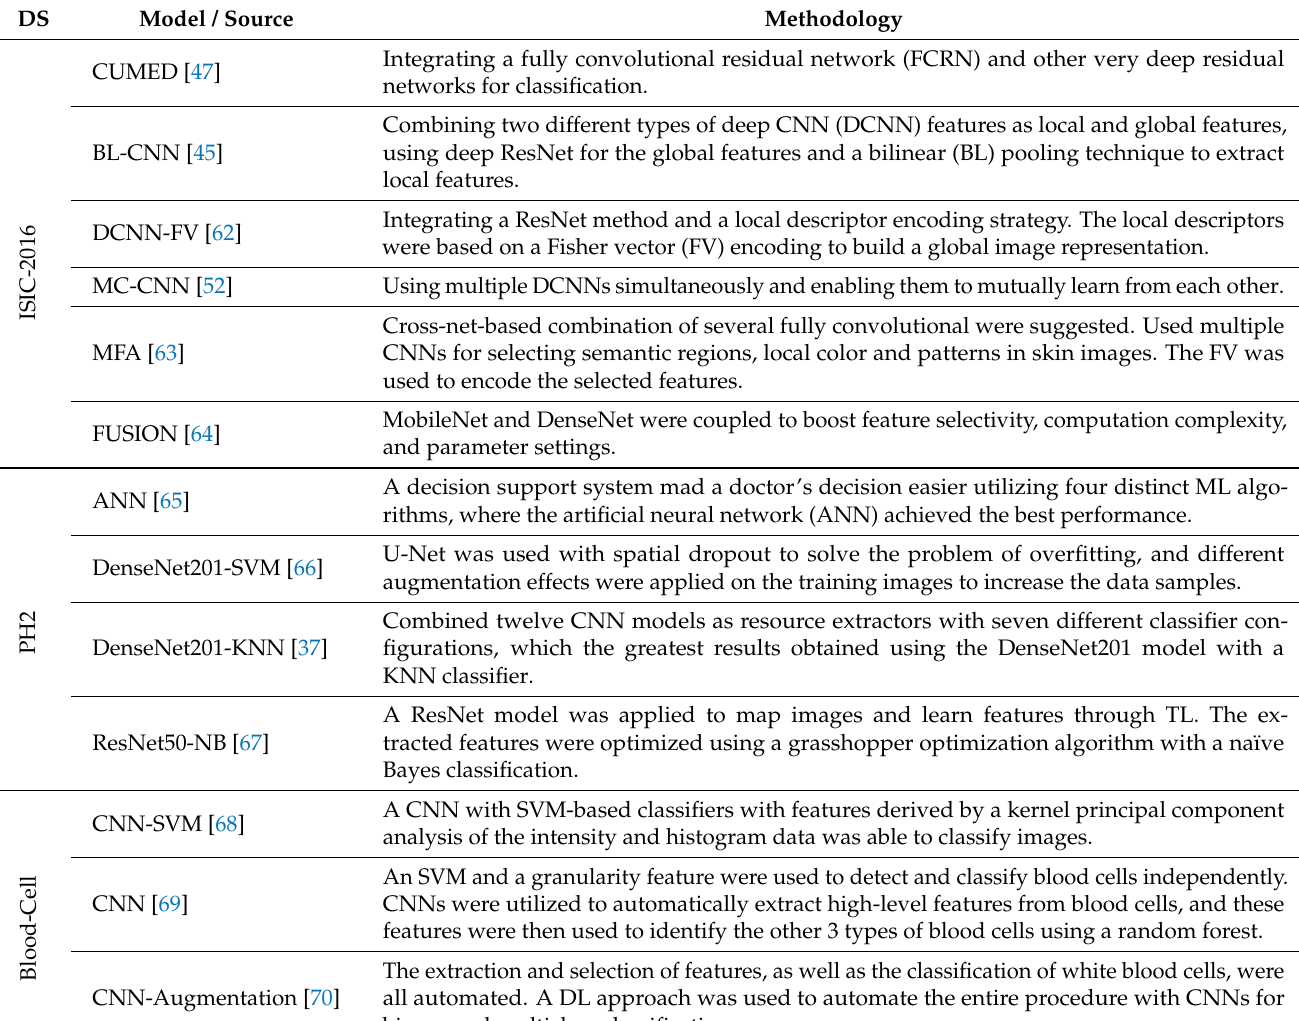
Table 1. The literature review on selected